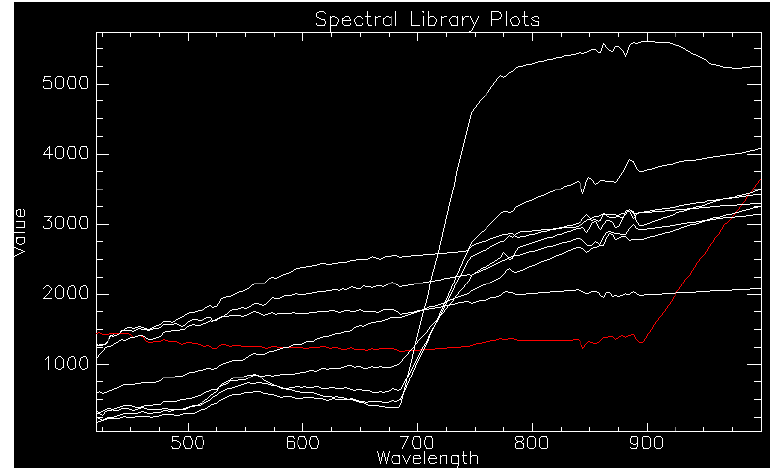
Figure 4: Spectral library from HySpex data resampled to DESIS spectral bands. The unit of measure is reflectance, multiplied by 10 4 . The solar panels class of interest is reported in red. Spectra in white include 4 vegetation spectra, plus 2 spectra belonging to soil, and 2 to man-made